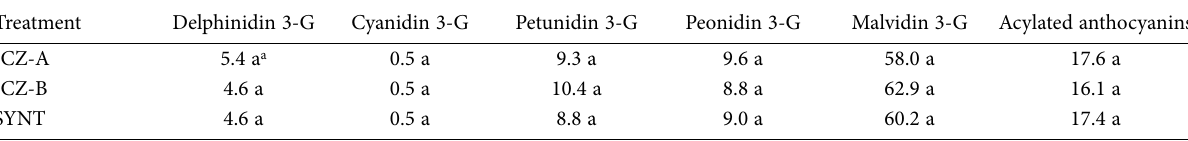
Table 11. Mean composition (%) of total anthocyanins in Montepulciano d’Abruzzo wines obtained from cv. Montepulciano vines in the CSA vineyard, treated in 2017 with Italian chabasite-rich zeolitites (ICZ-A and ICZ-B) or synthetic products (SYNT), after 3 months of age- ing. Montepulciano d’Abruzzo total anthocyanins included glycosylate and acylated forms (sum of acetate and coumarate